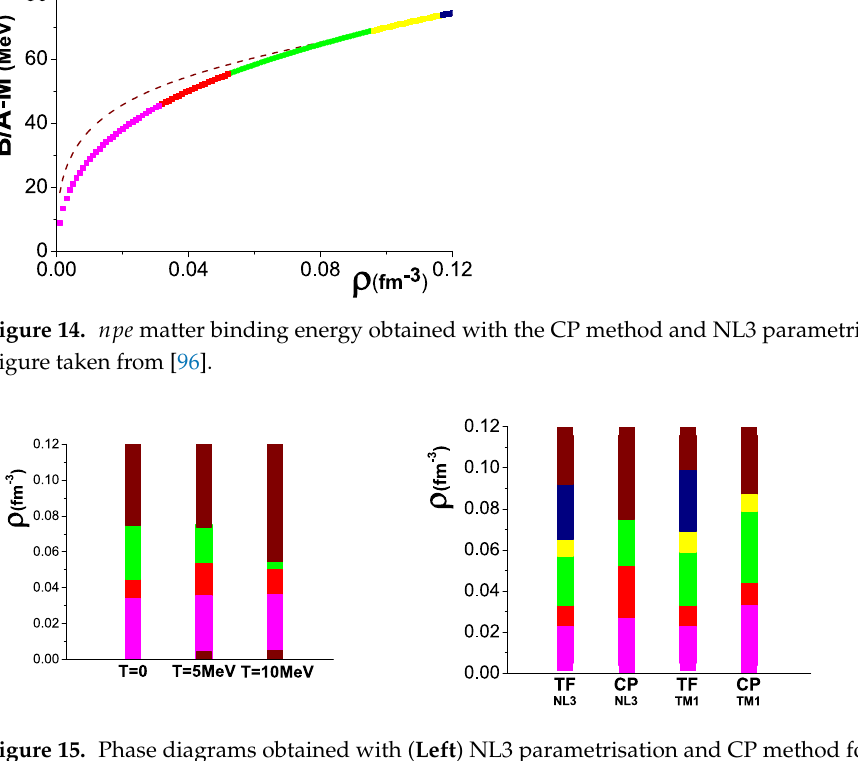
Figure 15. Phase diagrams obtained with ( Left ) NL3 parametrisation and CP method for Y p = 0.5. From bottom to top, the colors represent homogeneous phase ( T = 5 and 10 MeV only), droplets, rods, and homogeneous phase. ( Right ) NL3 and TM1 parametrizations with CP and TF methods for Y p = 0.3 and T = 0. Figures taken from